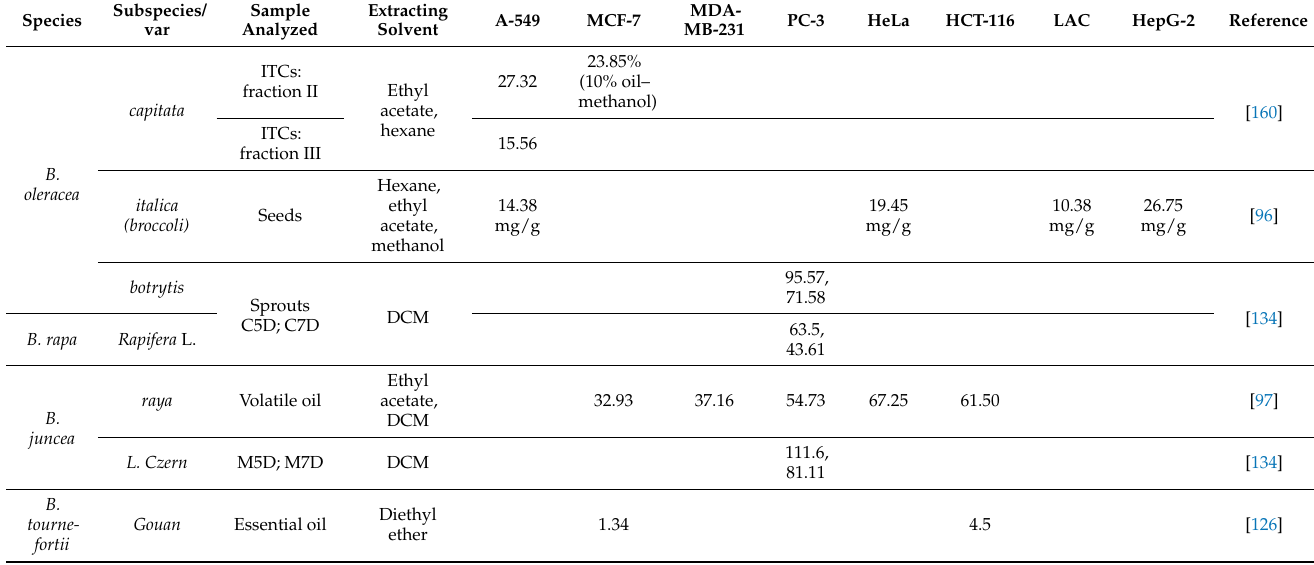
Table 6. Antiproliferative activity of the Brassica seed extracts IC 50 ( µ